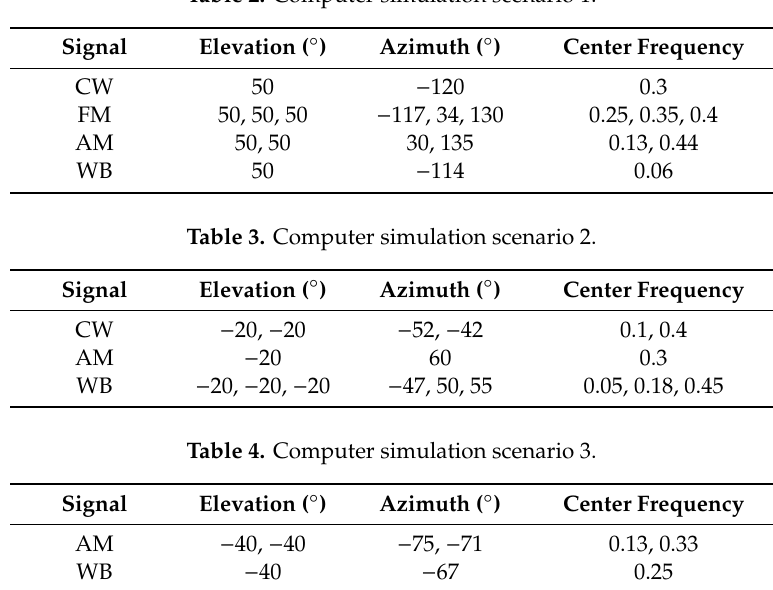
Table 2. Computer simulation scenario 1.